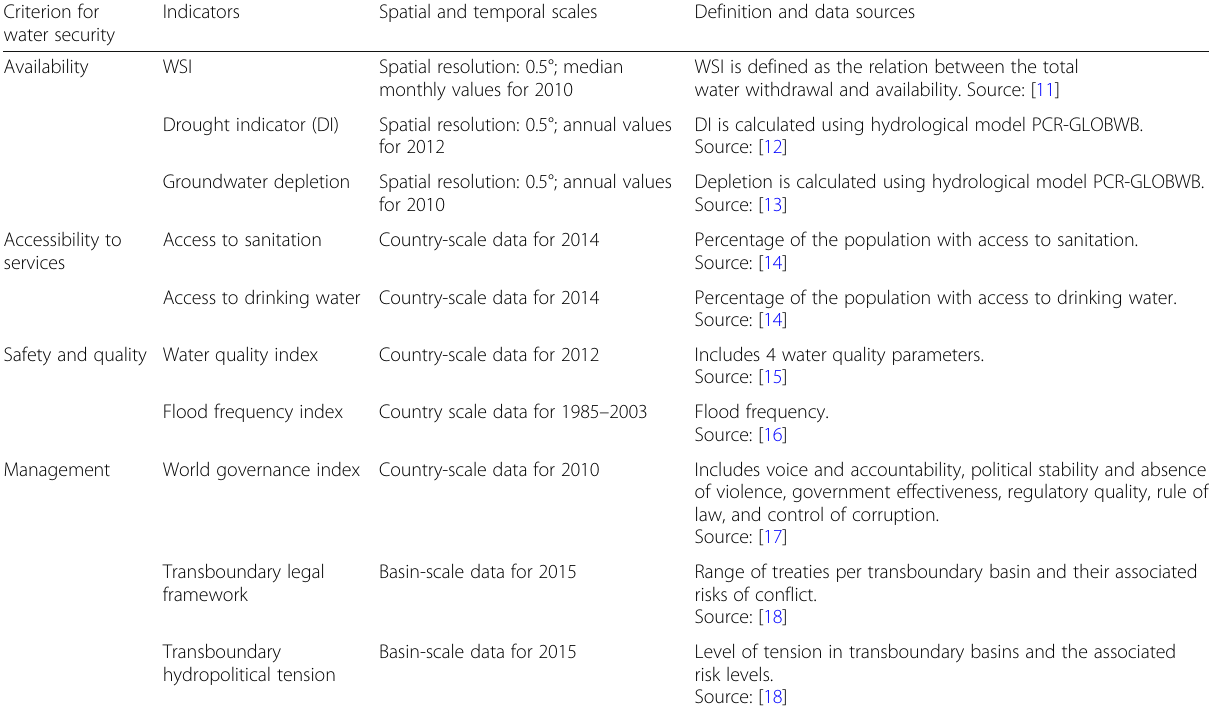
Table 1 Global water security index definition and data sources Criterion for water